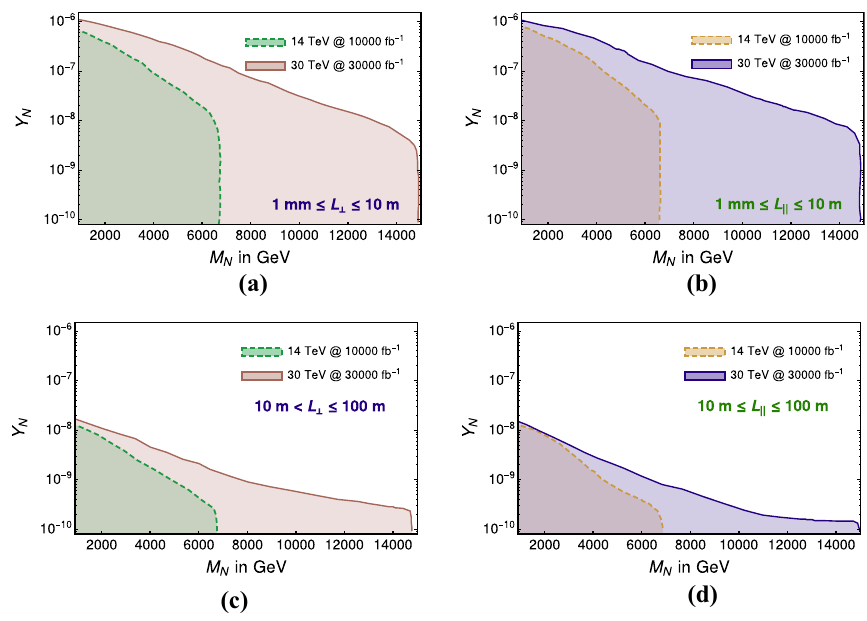
Fig. 29 Limits obtained for Yukawa coupling versus Type-III fermion mass via transverse ( a , c ) and longitudinal ( b , d ) decay lengths for the finalstates containing at least 2 b -jets with the centre of mass energies of 14 and 30 TeV at the muon collider with integrated luminosities of 10,000 and 30,000 fb − 1 , respectively. a , b Represent 1 mm ≤ L ⊥ , (cid:12) ≤ 10 m and c , d depict 10 m ≤ L ⊥ , (cid:12) ≤ 100 m